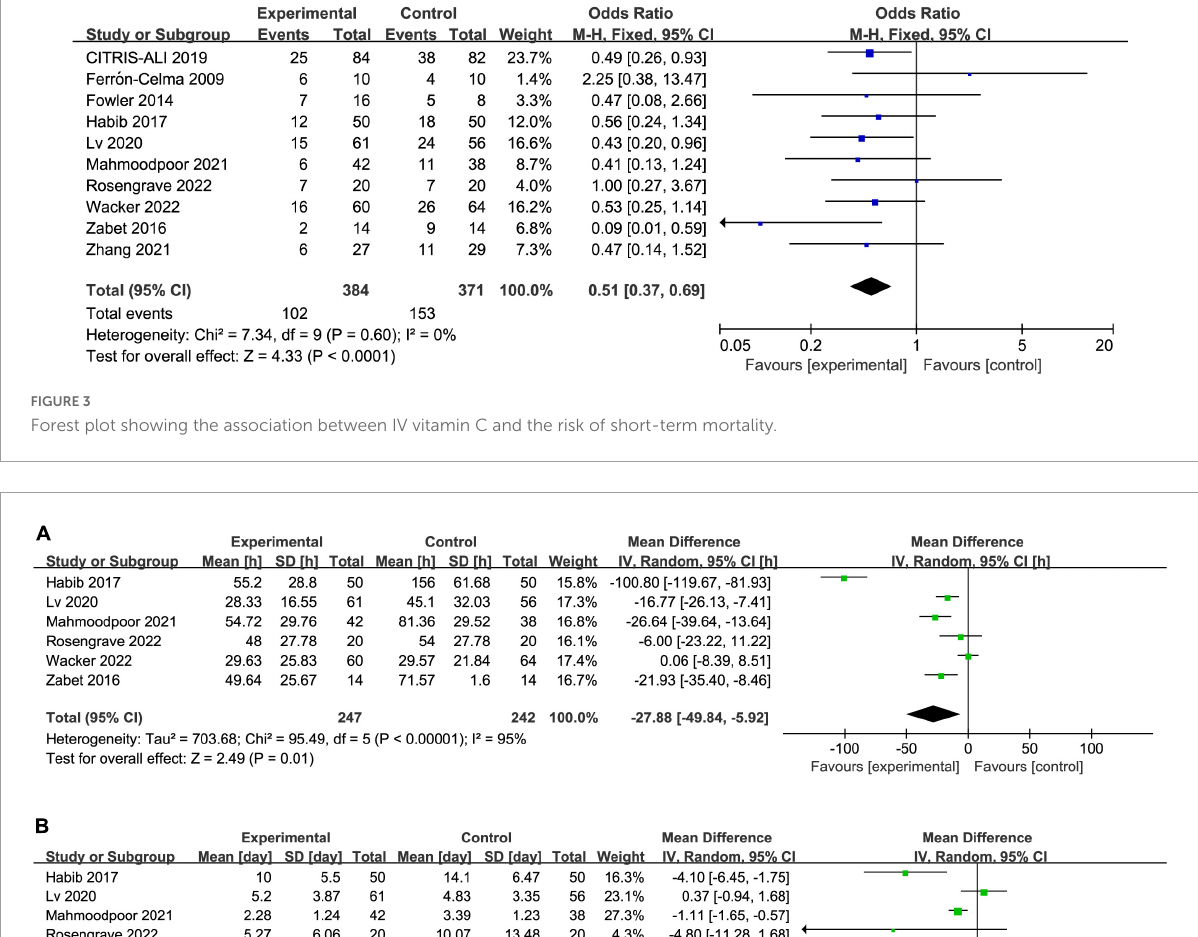
FIGURE4 Forest plot showing the association between IV vitamin C and (A) duration of vasopressor, (B) length of ICU stay, (C) SOFA score.